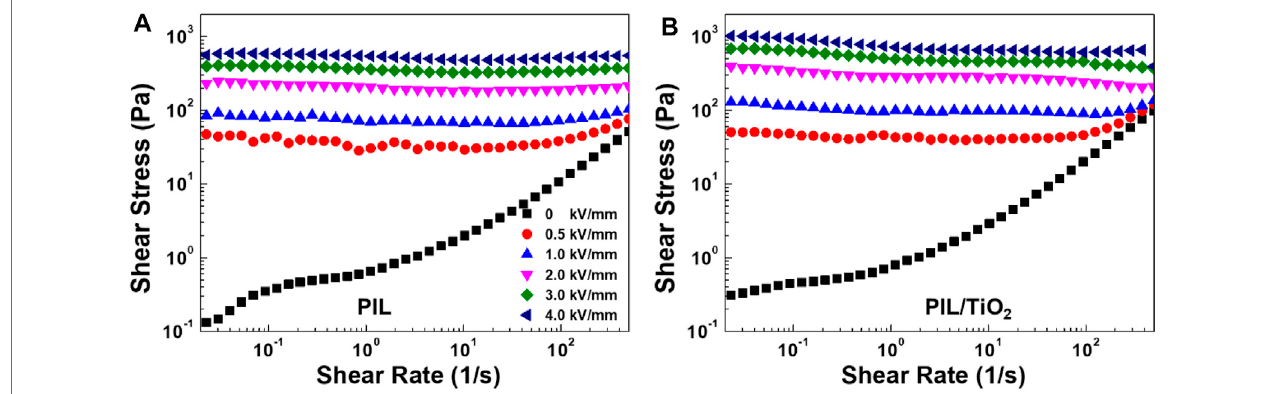
FIGURE 5 | Shear stress curves as a function of the shear rate of the ER fl uids of PIL (A) and PIL/TiO 2 (B) at 25 ° C under various electric fi eld strengths.